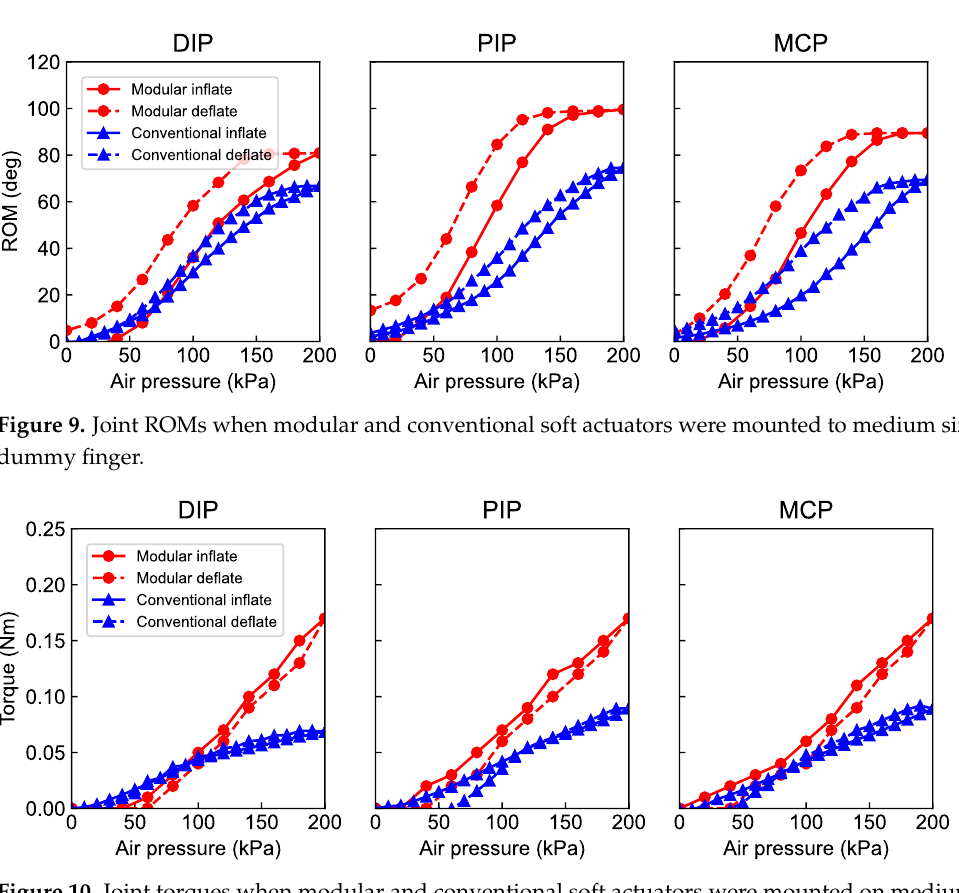
Figure 10. Joint torques when modular and conventional soft actuators were mounted on medium- sized dummy